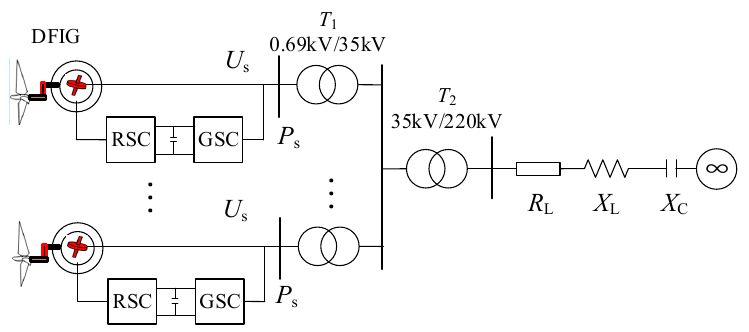
Figure 1. Double-fed inductive generator (DFIG) wind farm grid-connected system. In the dq-axis synchronous rotating coordinate system, the voltage and flux linkage equations of the stator and rotor can be expressed as follows: